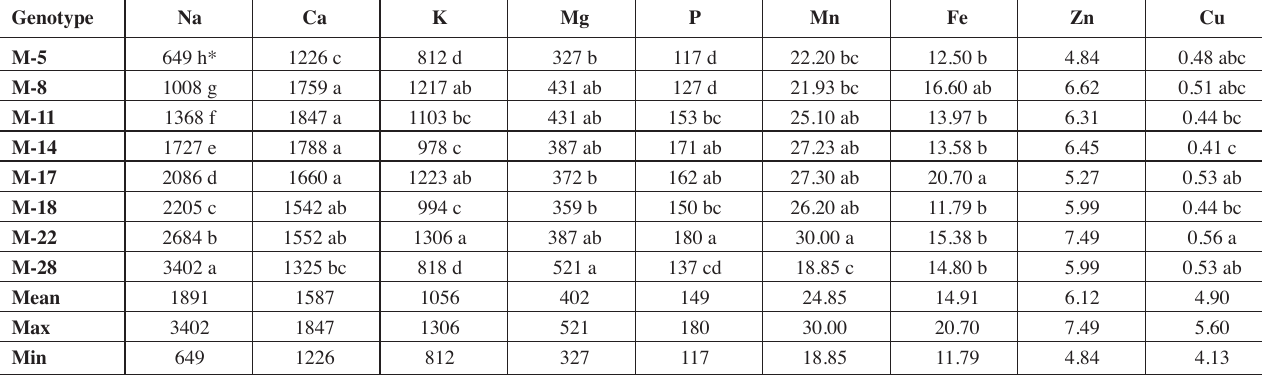
Tab. 3: Mineral composition of black mulberry leaves (mg/100